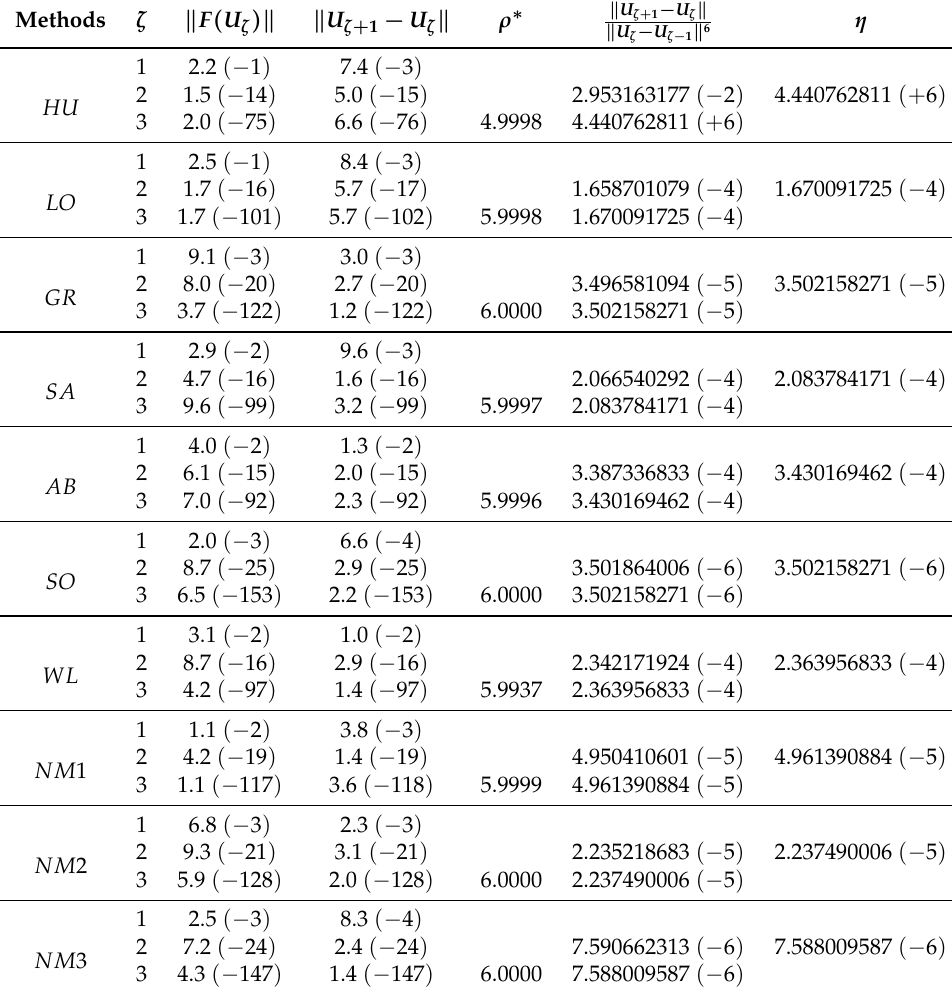
Table 7. Conduct of different techniques in Example